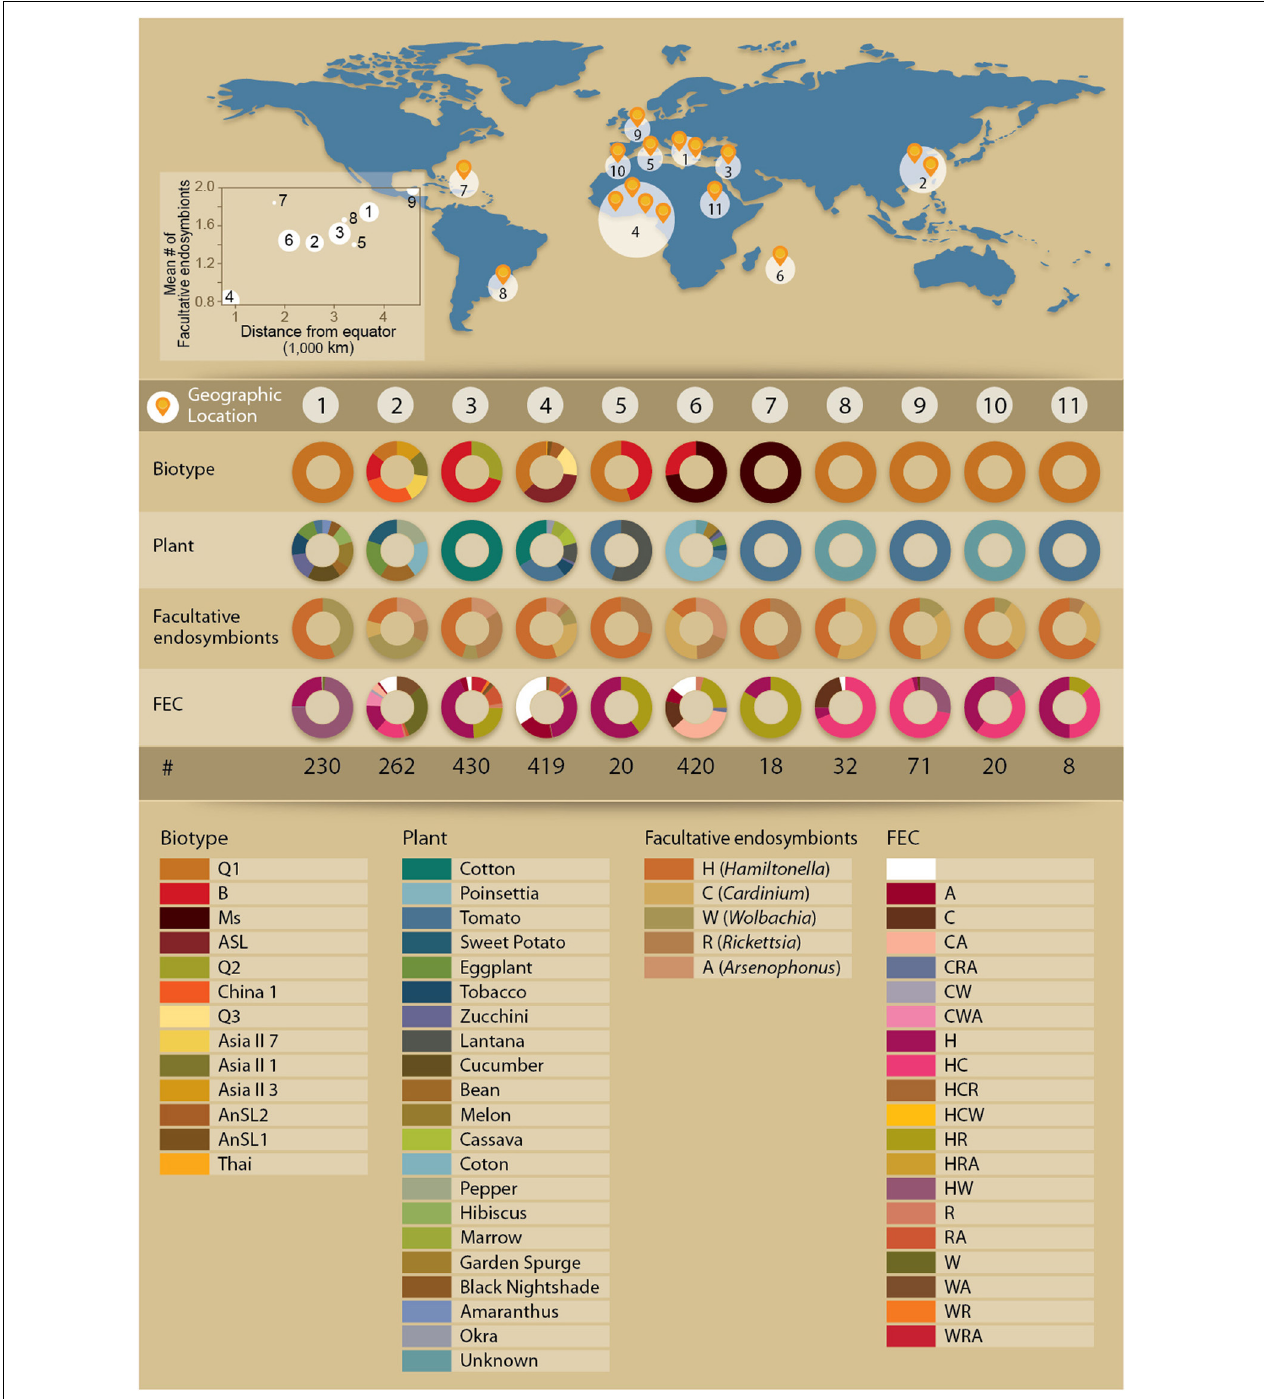
FIGURE 1 | Description of the dataset. Top : Collection sites of B. tabaci included in the dataset. In some cases, small samples from proximal locations were grouped (e.g., location 4 in West Africa). The plot on the left shows the mean genera richness of facultative endosymbionts co-infecting whitefly individuals in each location (Pearson correlation: 0.65, P -value 0.03). Circle sizes indicate the number of sampled individuals. Bottom : Distribution of B. tabaci biotypes, plants, and facultative symbionts in each geographical location. FS, facultative symbiont; FEC, facultative symbiont combination; #, sample size. Scientific names of the host plants: cotton ( Gossypium